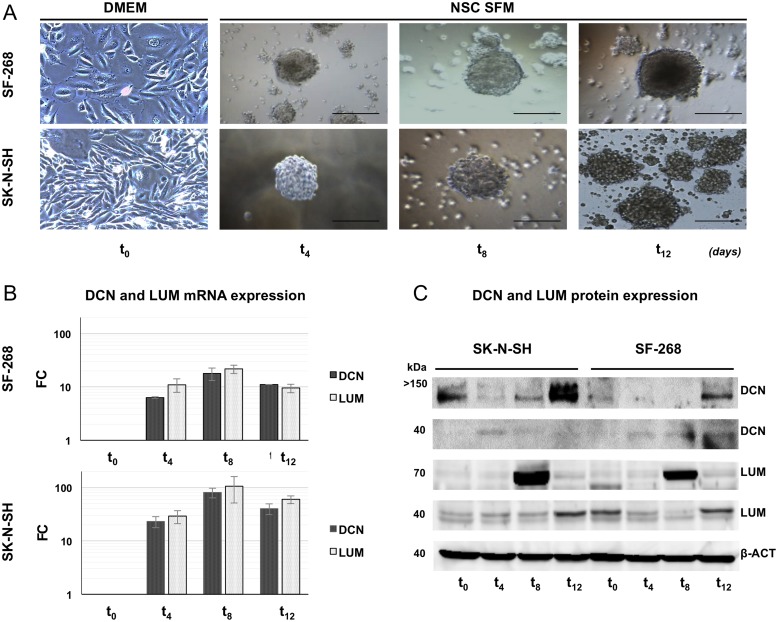
DCN and LUM mRNA/protein expression in GBM and NB CSC-like enrichments.(A) Neurosphere generation from SF-268 and SK-N-SH cell lines. Bar, 50 μm. (B) Expression of DCN and LUM mRNAs in CSC enrichment cultures. qRT–PCR results were normalized to ACTB and graphed as relative fold changes (FCs) between neurospheres at different time points (t4, t8, and t12) and adherent t0 cells with the 2–ΔΔCt method. All DCN and LUM FC values for the neurospheres were statistically significant (*p < 0.01). (C) Western blotting analysis of DCN and LUM. β-Actin was used as the loading control. Total DCN and LUM levels were higher in the neurospheres than in the adherent cells of both cell lines. A 70-kDa LUM isoform was upregulated in the neurospheres of both cell lines, with the highest expression in the t8 neurospheres. Adherent SF-268 cells showed basal expression of the 37-kDa LUM core protein.